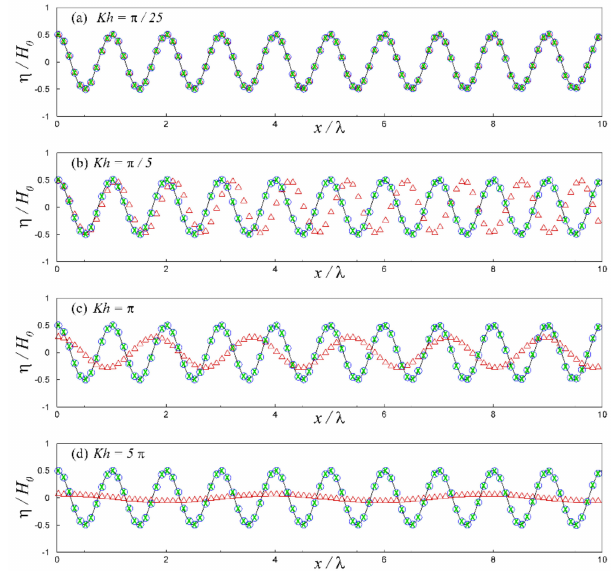
Figure 5. Comparison of the predicted free-surface spatial profile for ( a ) Kh = π / 25, ( b ) Kh = π / 5, ( c ) Kh = π , and ( d ) Kh = 5 π : analytical solution (solid lines), FNHS mode (circles), QNHS mode (X marks), and HS mode